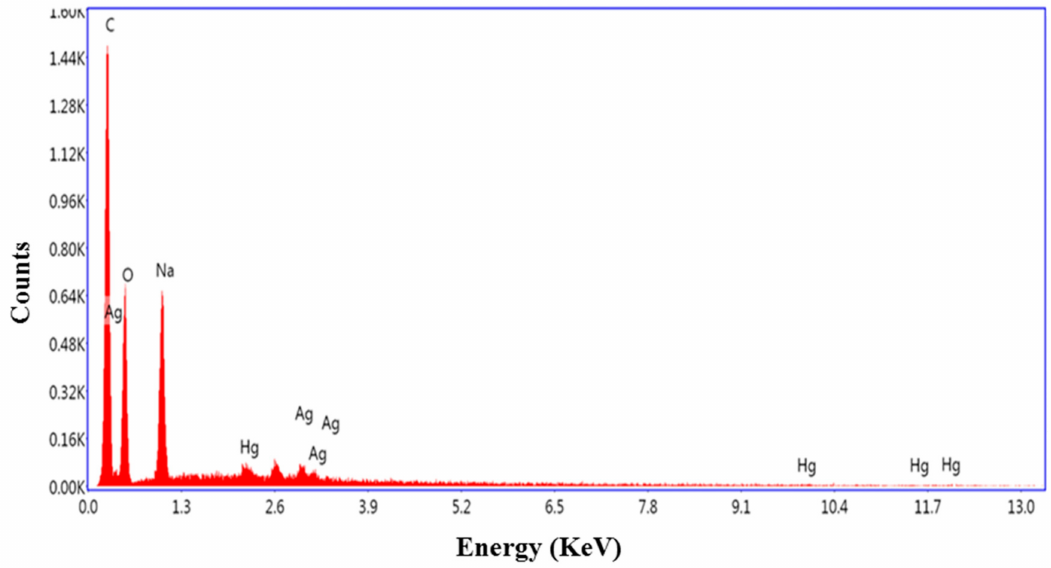
Figure 6. Elemental analysis, performed by energy dispersive X-ray spectroscopy (EDX), of Ag nanoparticles after exposure to mercury, indicating the formation of Ag-Hg amalgams.